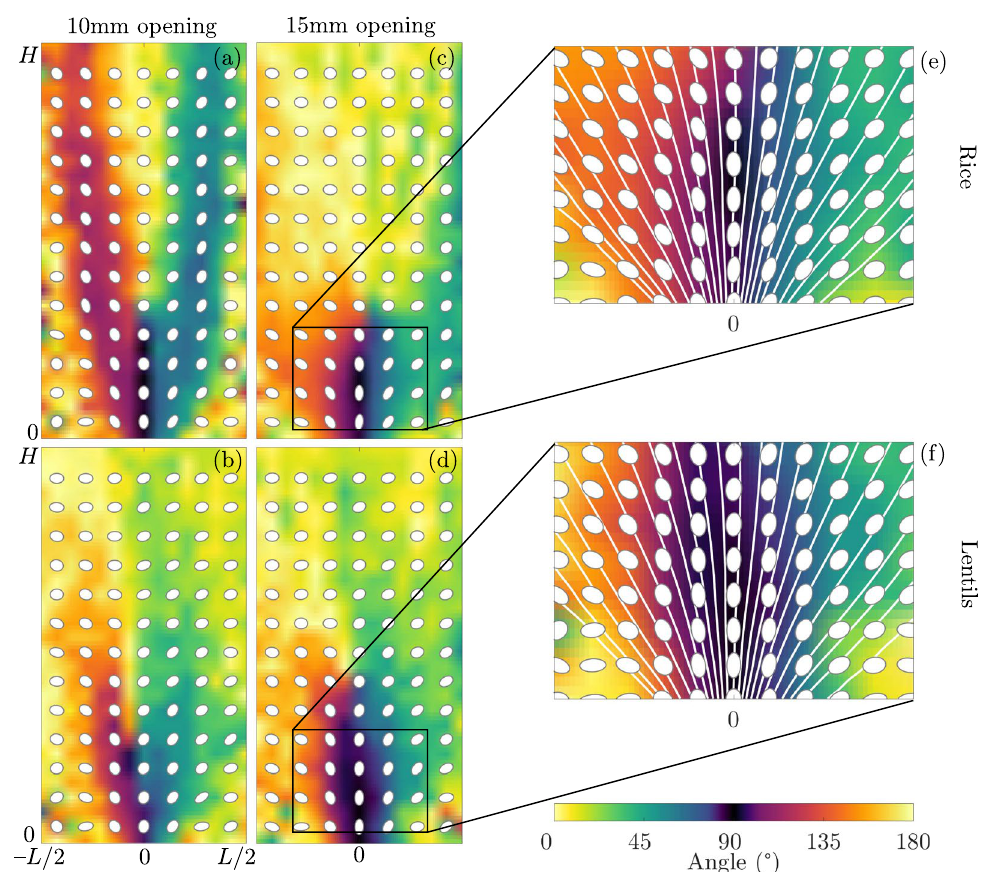
Figure 9. Principal particle orientation for rice ( a , c , e ) and lentils ( b , d , f ) measured from Fourier transforms. Colormaps represent the principal angle and ellipses represent the tensor T at their location. ( a – d ) Full field view of the silo, ( a , b ) 10 mm opening, ( c , d ) 15 mm opening. ( e , f ) Zoom near the outlet of the 15 mm opening, as indicated by the black rectangles in ( c , d ), with streamlines computed from Fig.